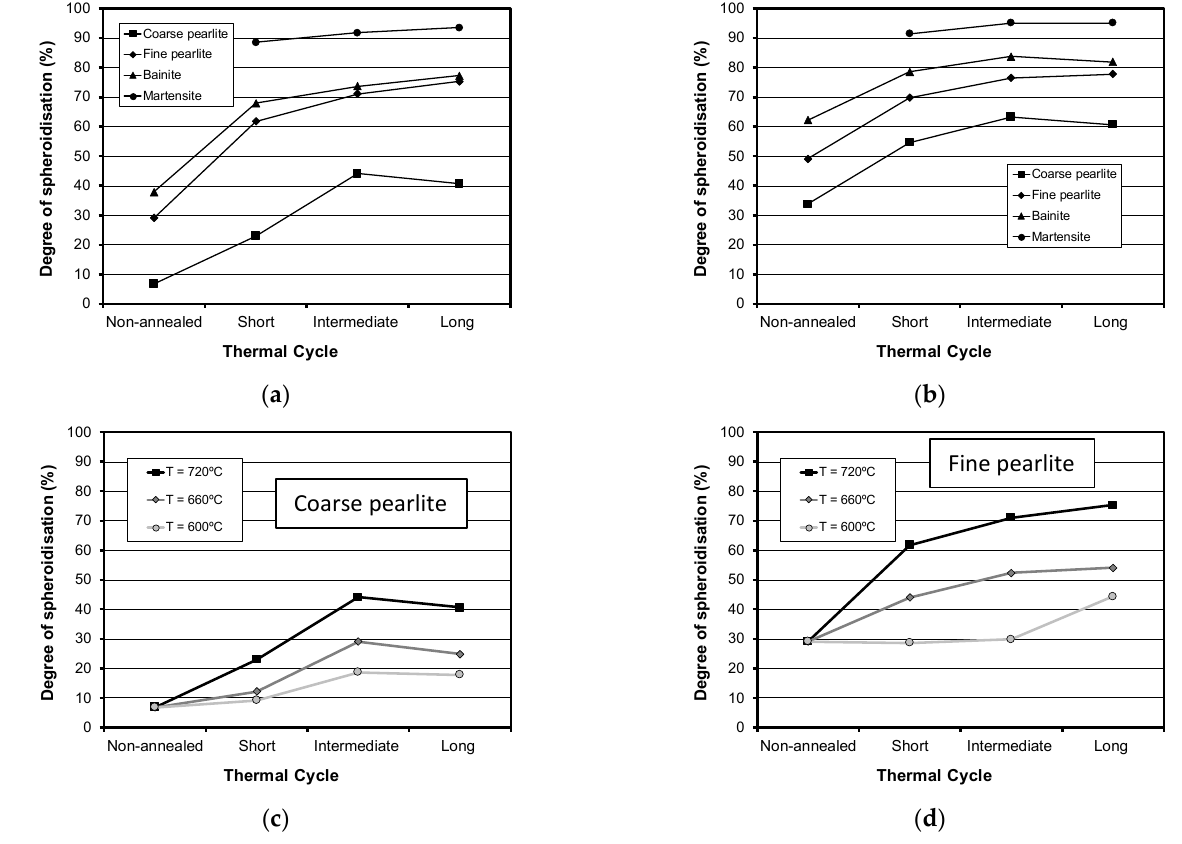
Figure 5. Evolution of the degree of spheroidization determined as spheroidized cementite area fraction ( a ) and spheroidized cementite frequency ( b ) for different initial microstructures. Influence of the annealing temperature on the spheroidization degree determined as spheroidized cementite area fraction for coarse ( c ) and fine ( d ) pearlite initial microstructure.